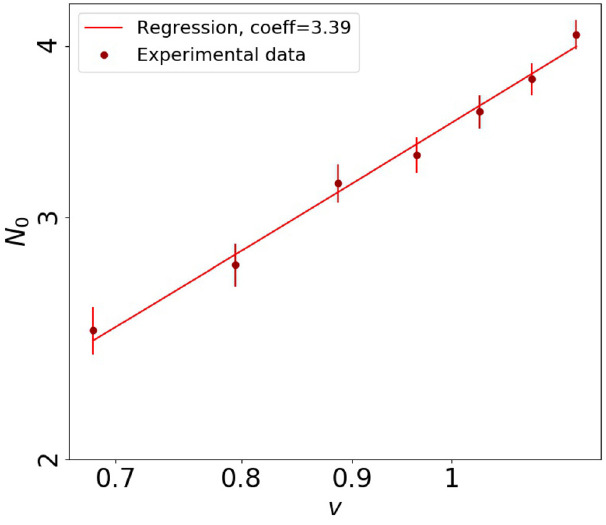
Fig. 8. Values of N 0 in function of the velocity v with a linear regression from which N 0 ∝ v 3 . 39 and r 2 = 0 . 97